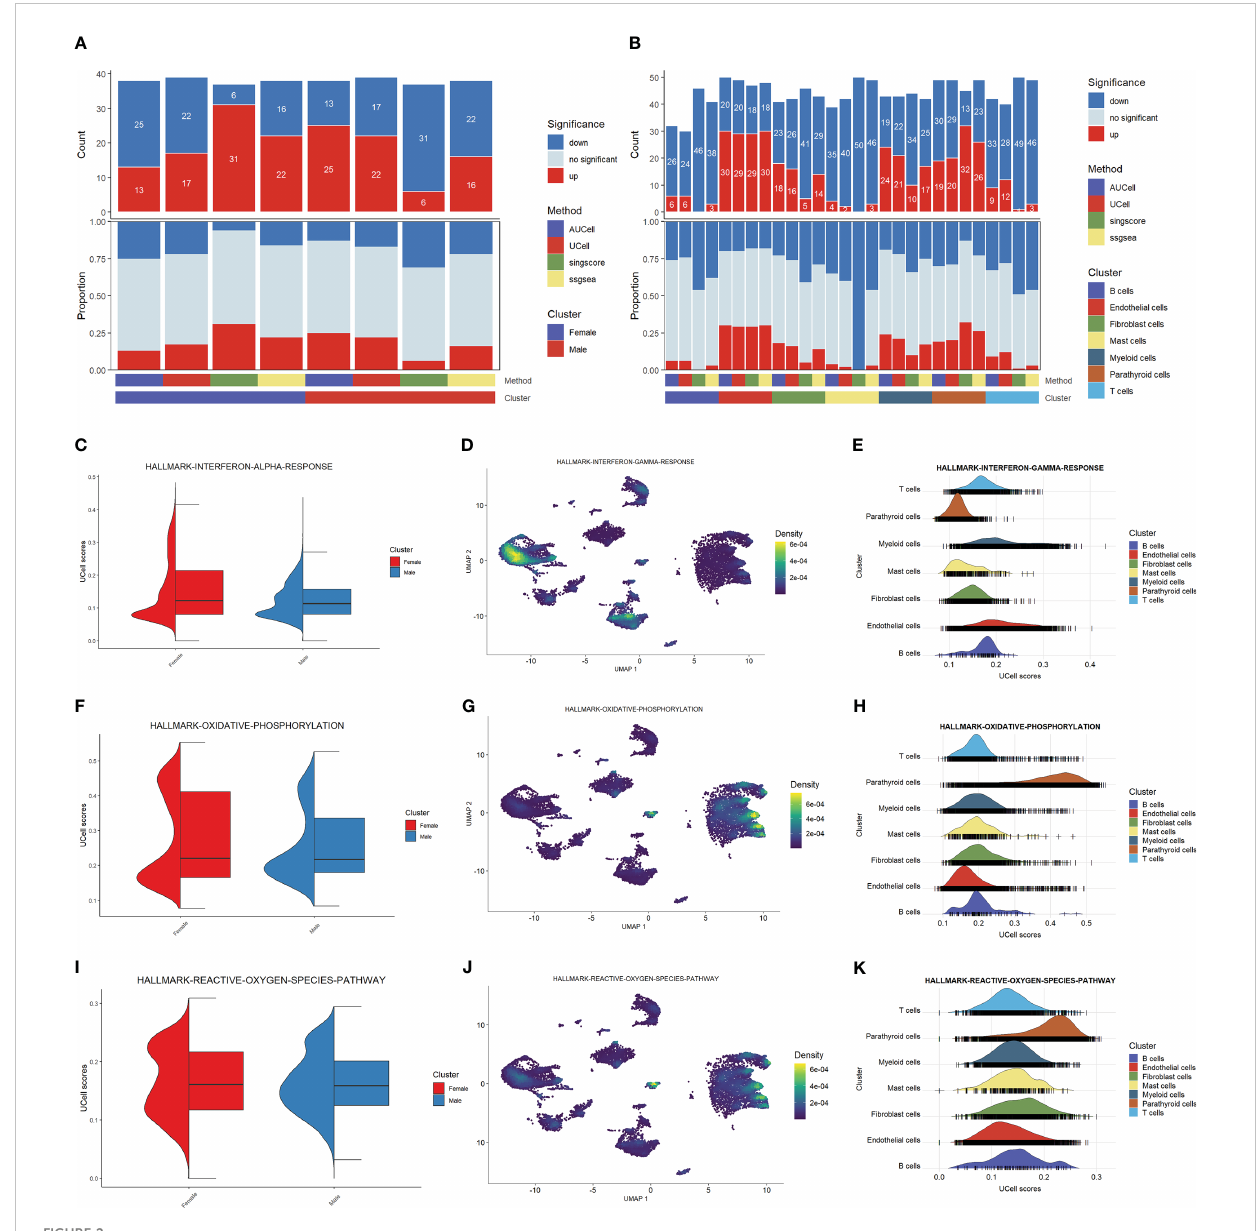
FIGURE 2 Functional analysis of PHPT patient samples. (A) Bar plot of the count and proportion of signi fi cant regulation pathways based on four different algorithms by sex. (B) Bar plot of the count and proportion of signi fi cant regulation pathways based on four different algorithms by cell type. (C-K) Pathway analysis of three key PHPT-related pathway, including interferon (C – E) , oxidative phosphorylation (F – H) , and reactive oxygen species (I – K) . Violin plots compare the UCell scores of these pathways between the two sexes (C, F, I) . Feature plots based on Umap show the pathway score distribution across all cell types (D, G, J) . Ridge maps show the pathway scores of each cell type (E, H, K)